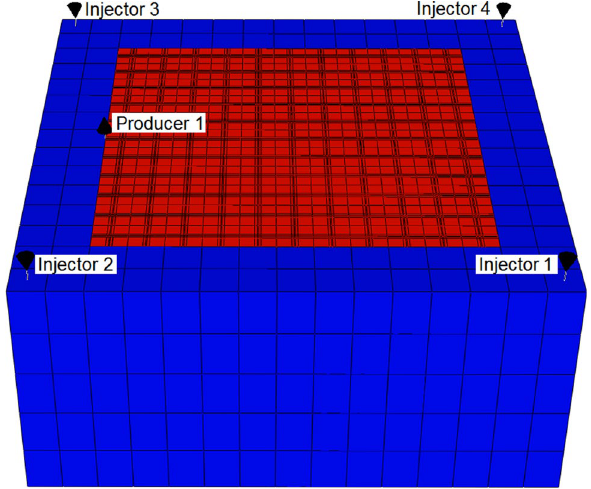
Fig. 1 Simulated five-spot pattern reservoir with the multifracturing area (Mohammad et al. 2016,